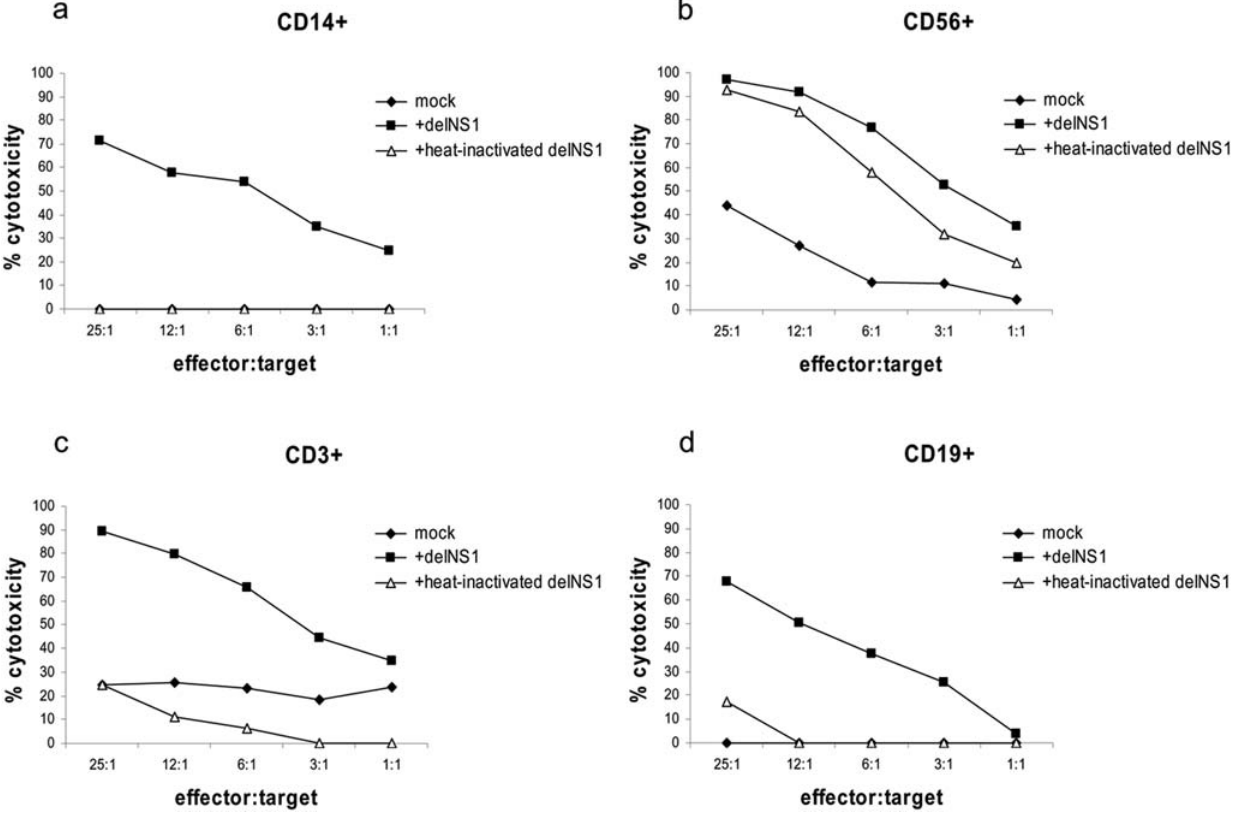
Figure 7. Induction of an anti-tumor cytotoxic immune response by infected monocultures. CD14 + (a), CD56 + (b), CD3 + (c) and CD19 + cells (d) were infected with delNS1 virus or heat-inactivated delNS1 (m.o.i.=0.02) and incubated for 24 hours. Then the cells were co-cultured with the target A375 cells for 24 hours and cytotoxicity was assessed. One representative result in percentage of cytotoxicity is shown of three independent experiments, each performed with cells derived from a different donor.